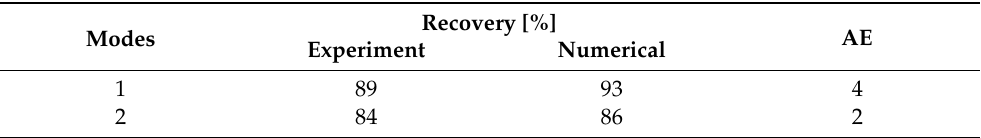
Table 6. Comparison of the results of numerical calculation of the degree of uranium extraction with the experimental one for regimes 1 and